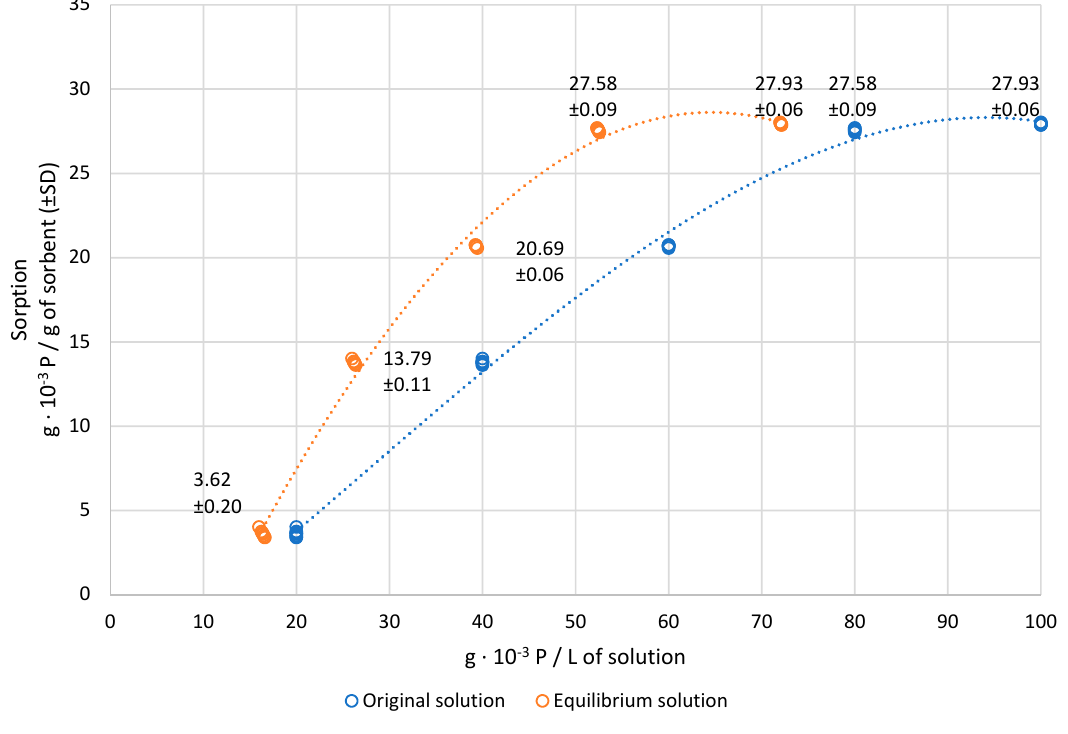
Figure 2. Adsorbed amount of phosphorus at different concentrations of solution.